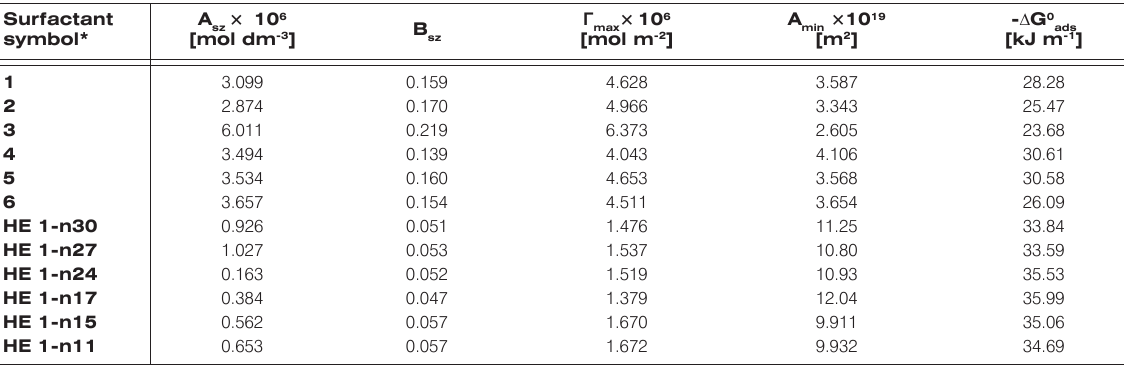
Surfactant symbol*